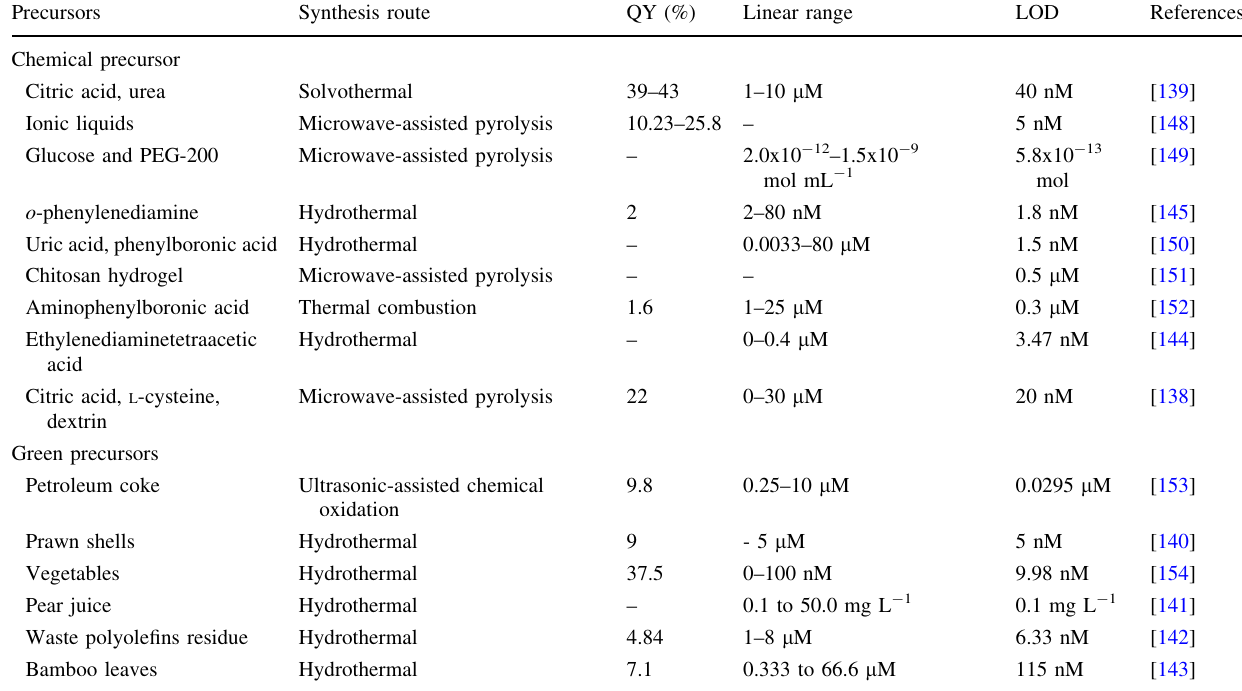
Table 3 Recent advances in the preparation of CDs, their corresponding properties, and Cu 2 ? ion sensing